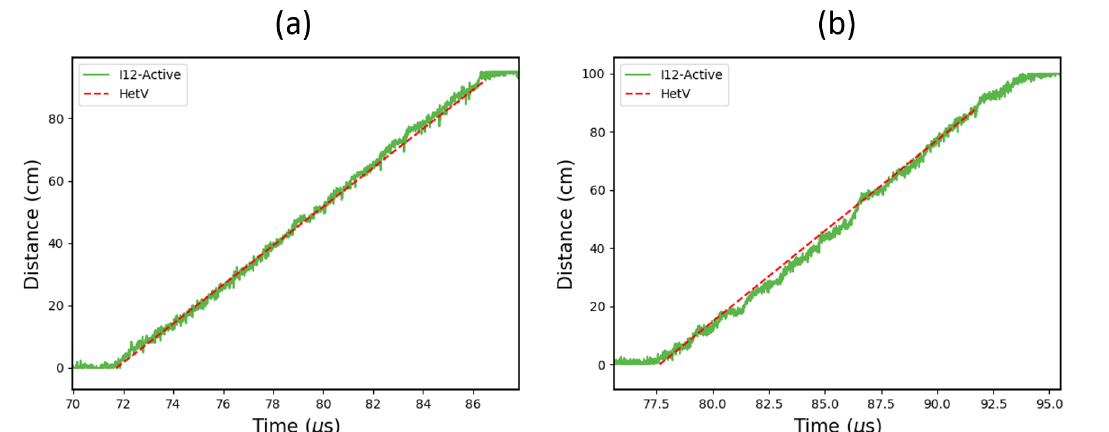
Figure 5. Plots showing the data from two 1-m long Er-doped fibre detonation velocity tests (Fibrecore I-12). For comparison, the data has been overlaid with the corresponding HetV results. The results shown in ( a , b ) are from two nominally identical cylinder tests. However, a substructure, thought to be due to the helical mounting geometry, is particularly present in Figure